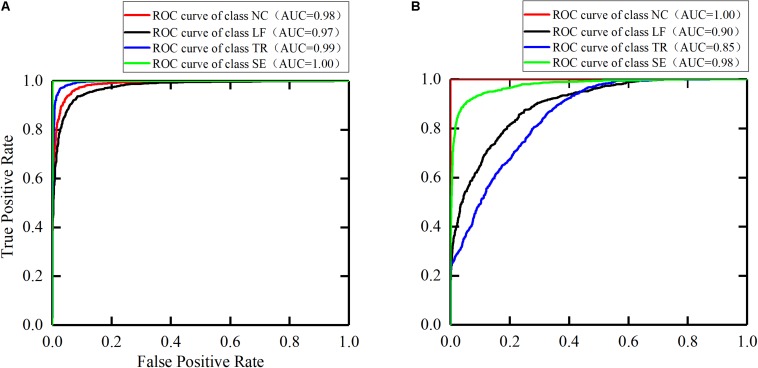
The ROC curves for the trunk compensation detection models. (A) The healthy group. (B) The stroke group. NC, no compensation; LF, lean-forward; TR, trunk rotation; SE, shoulder elevation.